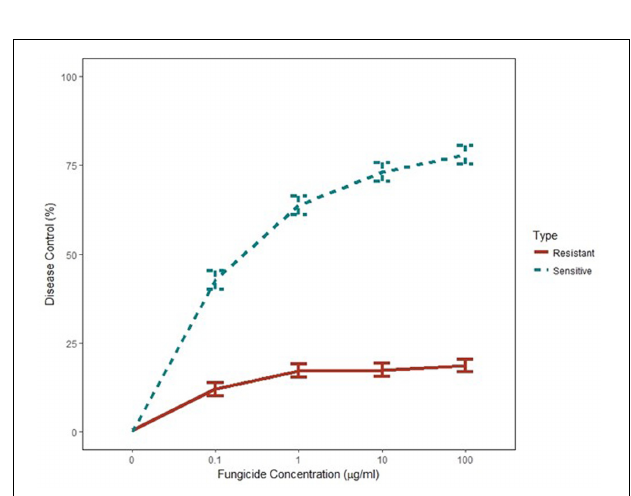
developed, evaluated and analyzed on the Biorad CFX96 real- time PCR detection system (Bio-Rad Laboratories, Inc., Hercules, CA, United States).